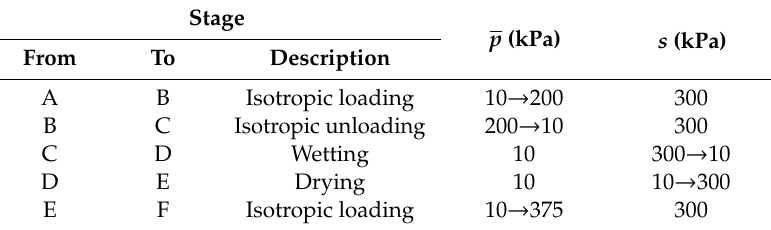
Table 2. Stress paths of Test